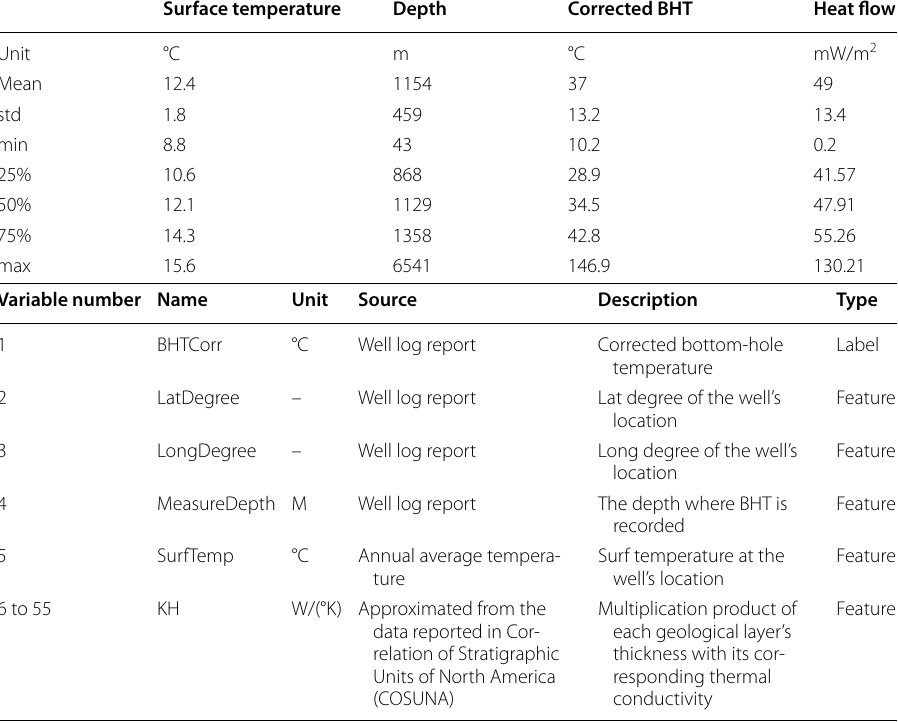
Table 1 Statistical summary of important parameters after outlier removal Surface temperature Depth Corrected